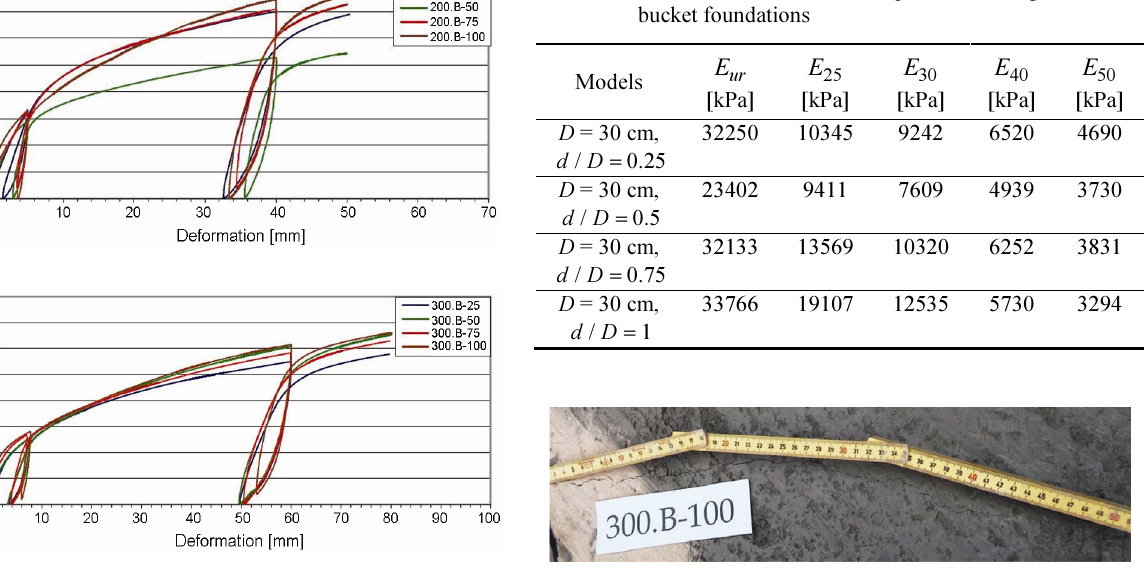
Table 6. E -moduli calculated from experiments using 30-cm